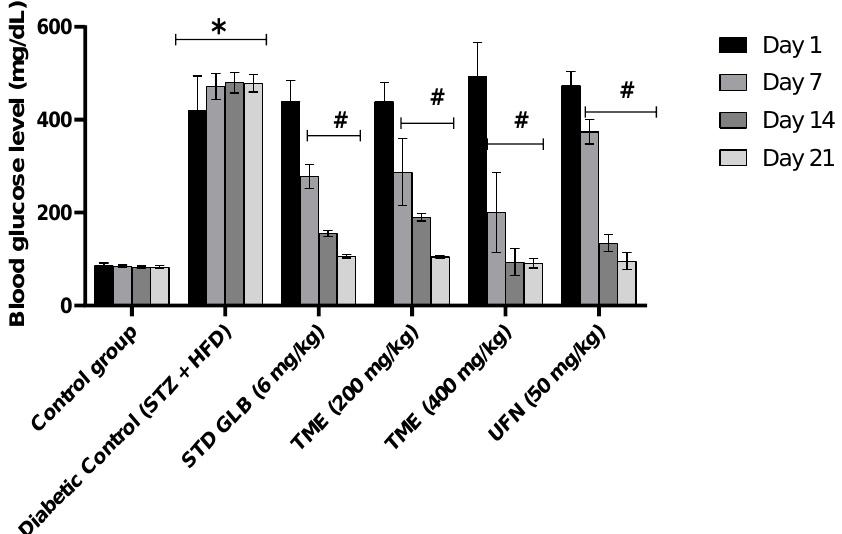
Figure 2. Effect of TME (200 and 400 mg/kg) of B. eriophora and UFN (50 mg/kg) on the blood glucose level. Data are represented as mean ± SD, n = 6. * represents a significant difference between the control group and the diabetic control group. Whereas # represents a significant difference between the diabetic control group with all the treatment groups of TME and UFN. STZ; streptozotocin, STD GLB; standard glibenclamide, TME; total methanol extract, UFN; umbelliferone.